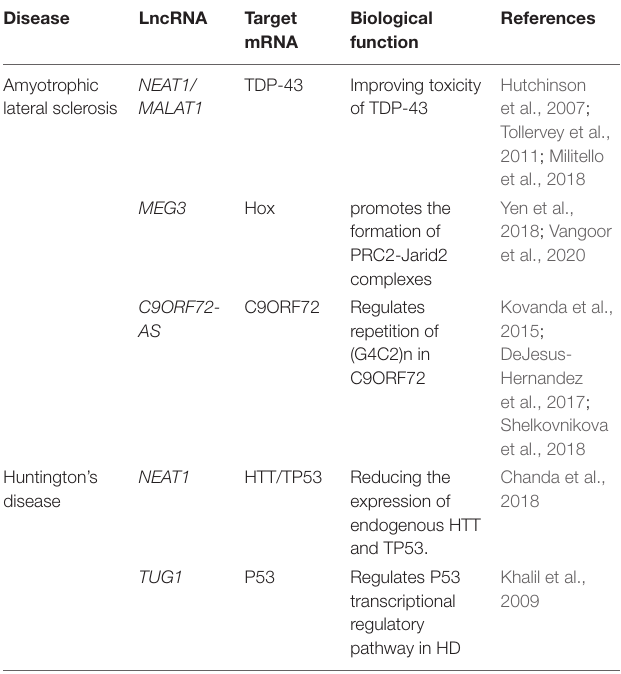
TABLE 3 | Main dysregulated long non-coding RNAs in Huntington’s disease and amyotrophic lateral sclerosis. Disease